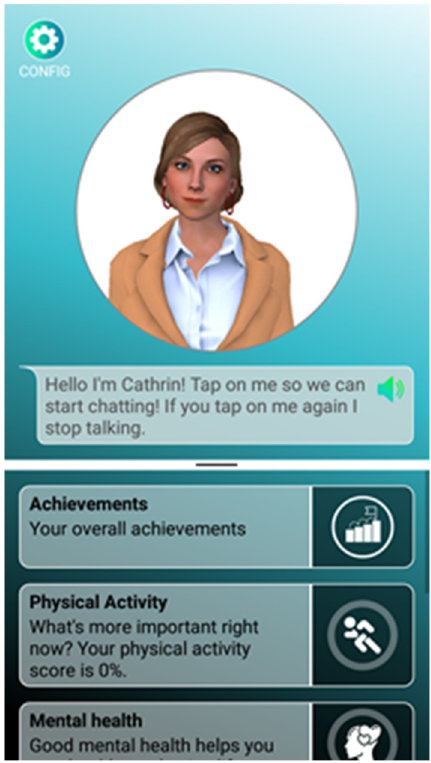
Figure 1. Home of the avatar-based app.